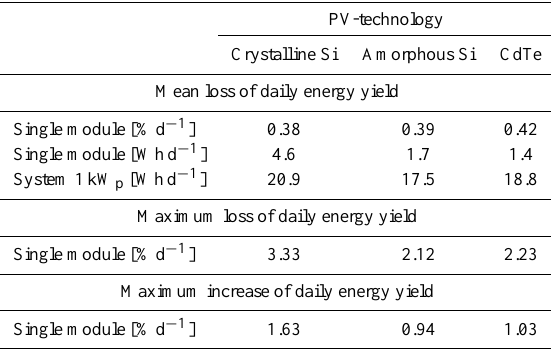
Table 1. Energy yield losses for the given PV-technologies. The mean values in % are statistical values, the mean values in Wh were calculated from the fit in Fig. 6.